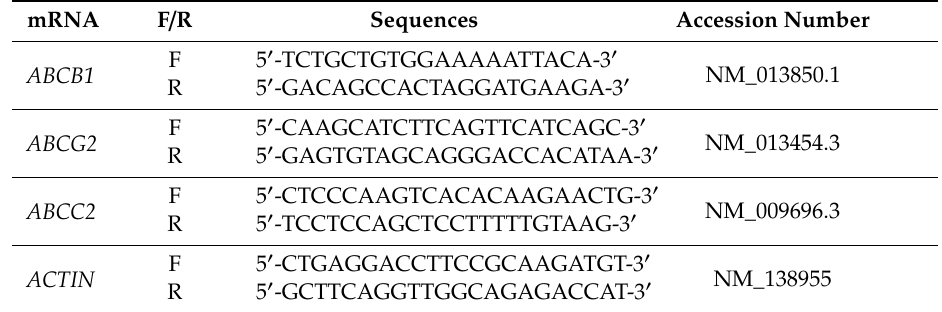
Table 2. From left to right: cDNA targeted for amplification, Forward (F), Reverse (R) primer designation, 5 (cid:48) to 3 (cid:48) primer sequence, accession numbers of cDNA from NCBI